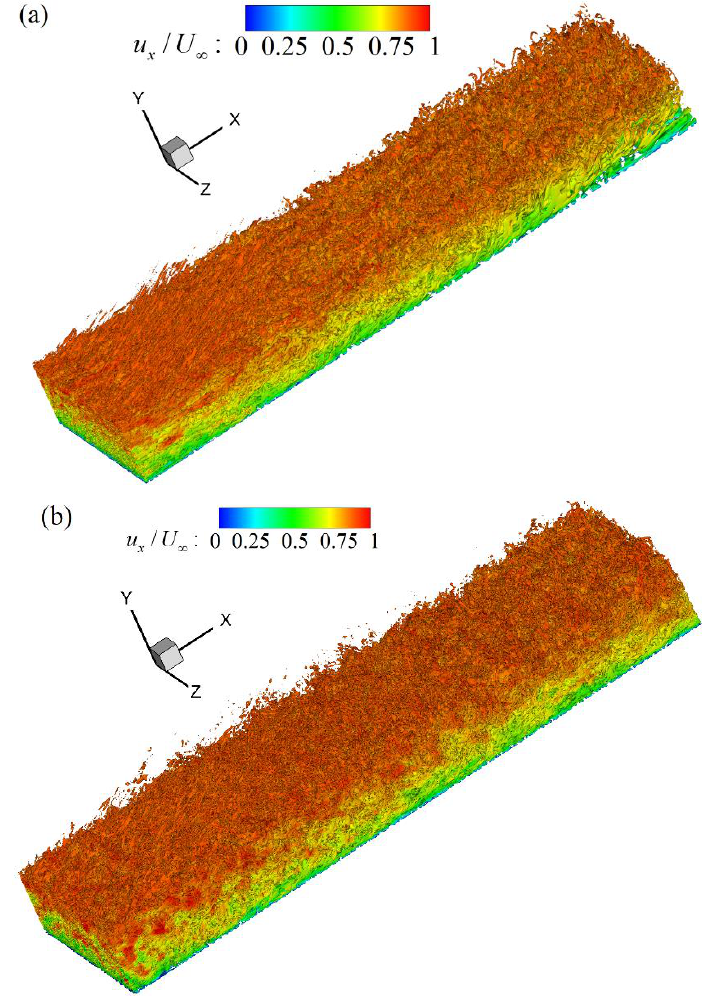
Figure 10. Isosurfaces of the second invariant Q colored by the streamwise velocity for the ( a ) traditional SEM and ( b ) improved SEM.